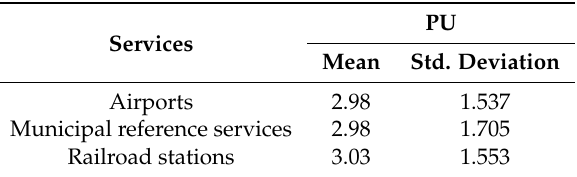
Table 8. Ranking of information about